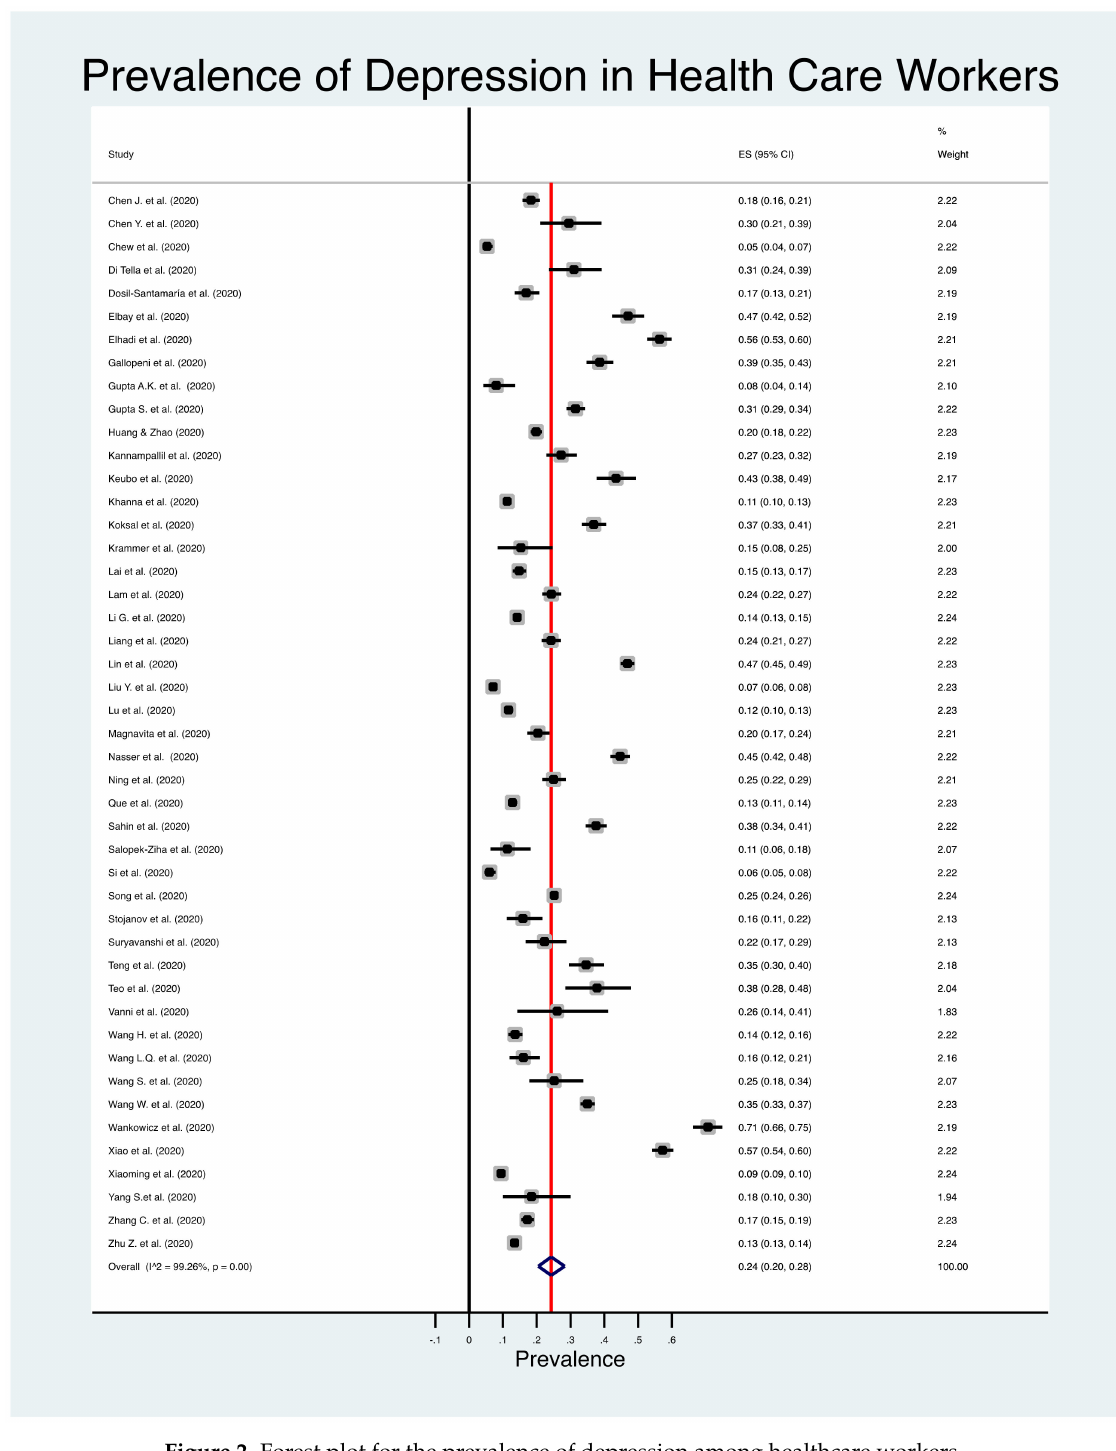
Figure 2. Forest plot for the prevalence of depression among healthcare